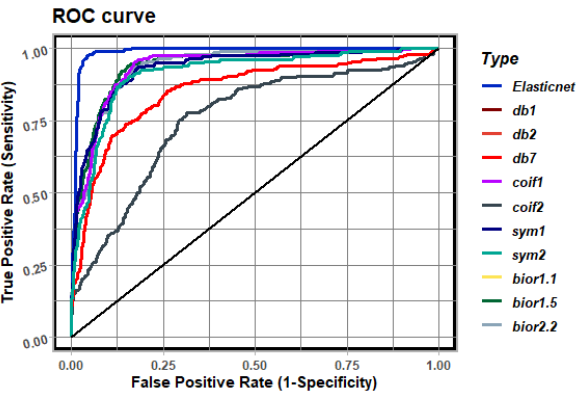
Figure 11. ROC analysis for example 3.